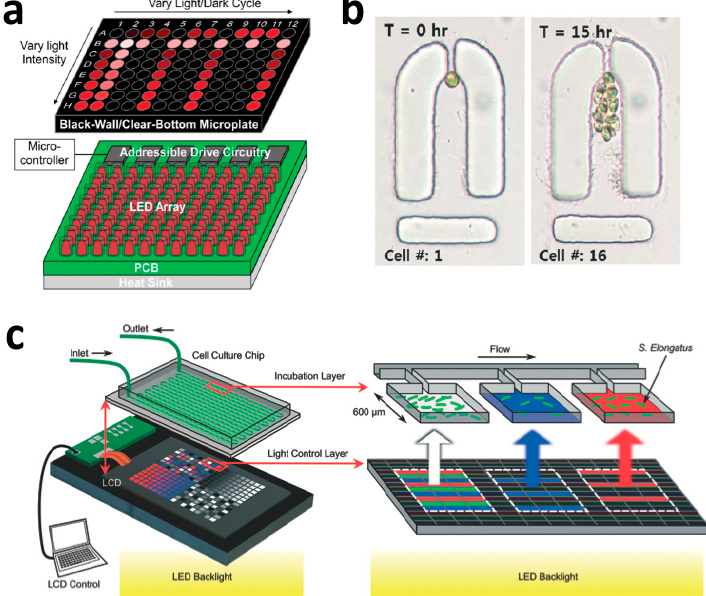
Figure 3. High throughput screening microfluidic platform ( a ) 96-well microplates [37]. An array of LEDs is utilized in conjunction with a microcontroller to provide light illumination; Reproduced with permission from Lab on a chip; published by Royal Society of Chemistry, 2012. ( b ) Single-cell capture sites [41]. Single-cell resolution growth profile of C. reinhardtii showing cell division inside the cell trap site for a 15-h period; Reproduced with permission from Lab on a chip; published by Royal Society of Chemistry, 2015. ( c ) Liquid crystal display (LCD) pixel-based photobioreactors [44]. The platform consists of a PDMS-on-glass cell culture chip, a programmable LCD screen and an LED array backlight to deliver the multiplexed illumination to cyanobacteria. The irradiance intensity, time variance and spectral composition can be individually controlled for each experiment. Reproduced with permission from Lab on a chip; published by Royal Society of Chemistry,